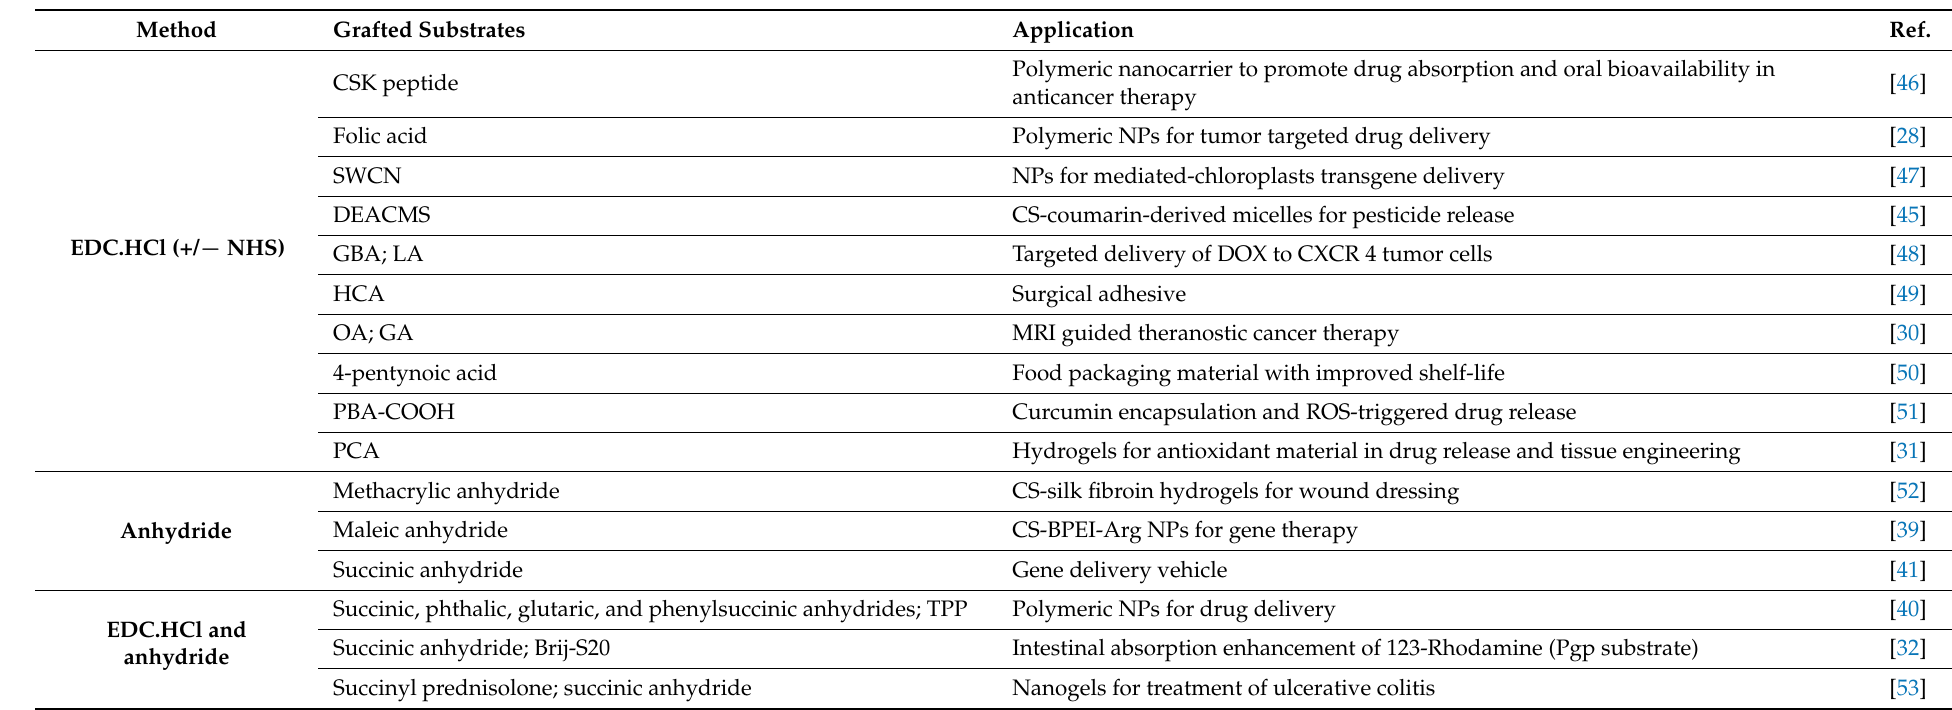
Table 1. Amide bond formation on CS systems and applications of the resulting